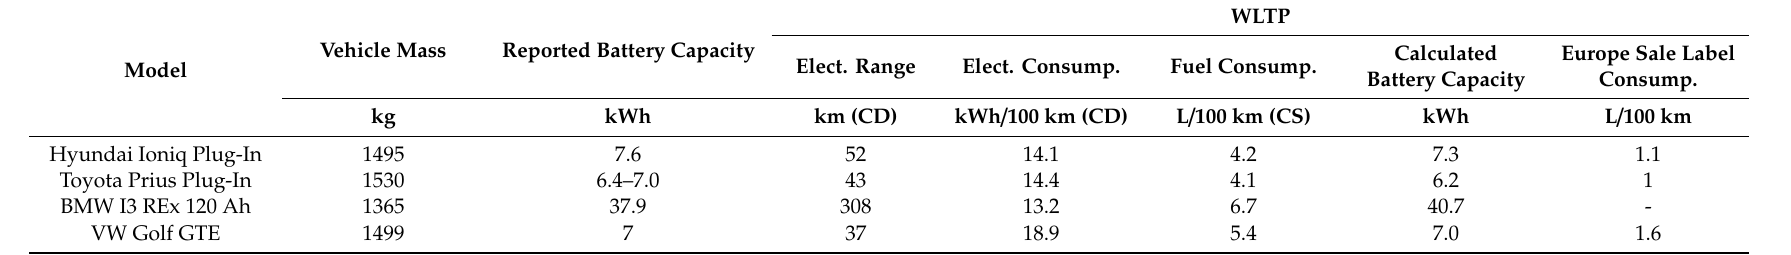
Table 1. Specifications for some of the most popular plug-in hybrid electric vehicles (PHEVs) in the